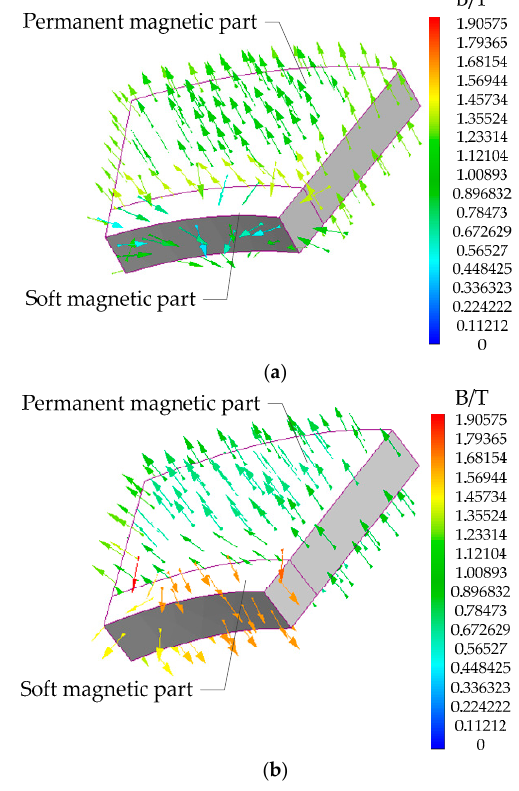
Figure 3. Flux distribution of a rotor pole: ( a ) In no-load condition; ( b ) In demagnetization condition.